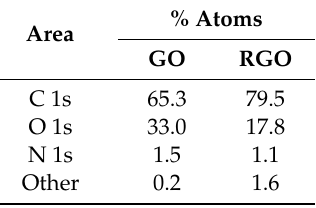
Table 1. Concentration of atoms in the structure of GO and RGO obtained from XPS survey